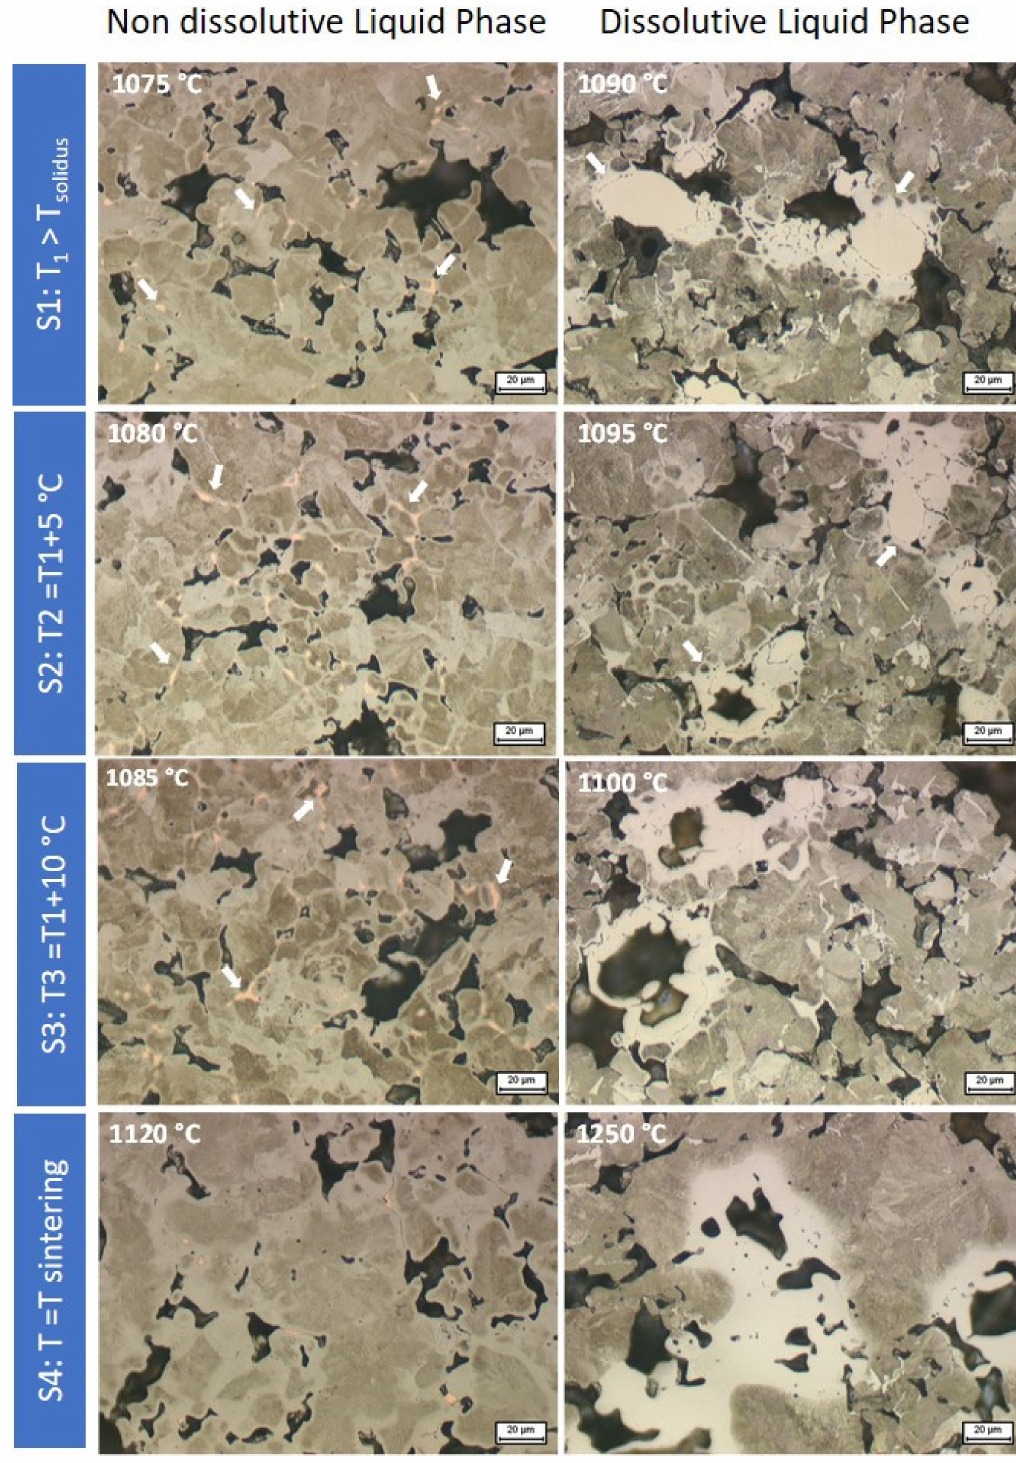
Figure 14. Microstructures of Fe-0.7%C steels modified by Cu-Mn-Si MA in each interrupted sintering stage, in Ar atmosphere and rapid cooling (100 ◦ C/s) in the presence of: left, a non-dissolutive and right, dissolutive liquid